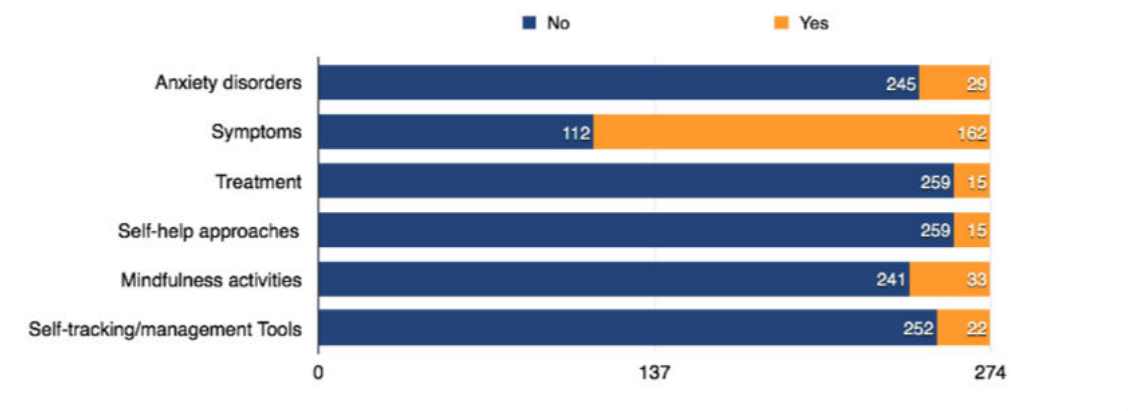
Figure 4. Number of app titles related to anxiety disorders, symptoms, treatment, self-help approaches, mindfulness activities, and self-tracking or management tools.